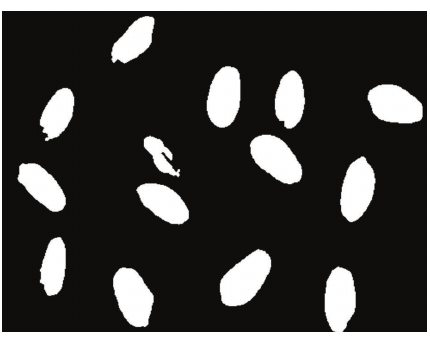
Figure 2: Preprocessing